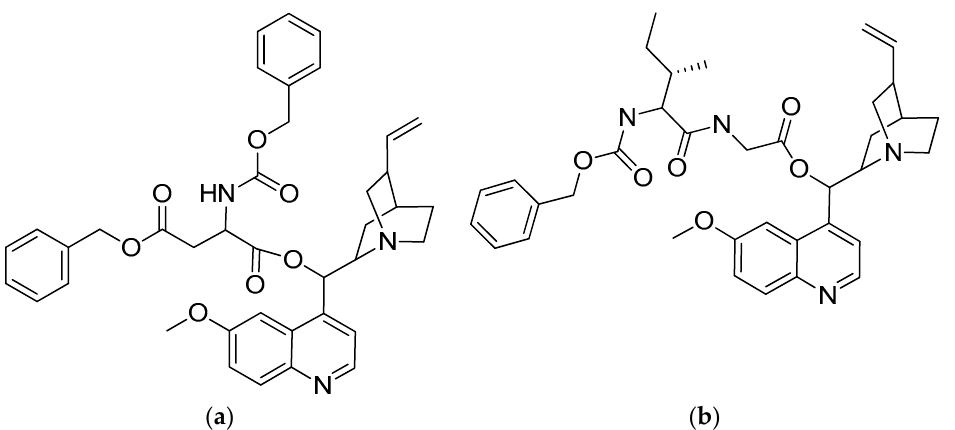
Figure 6. ( a ) Acylbenzotriazoles-L-aspartic acid-quinine; ( b ) acylbenzotriazoles-L-isoleucine-glycine-quinine. Table 3. In vitro antimalarial activities of compounds against the chloroquine-sensitive 3D7 strain